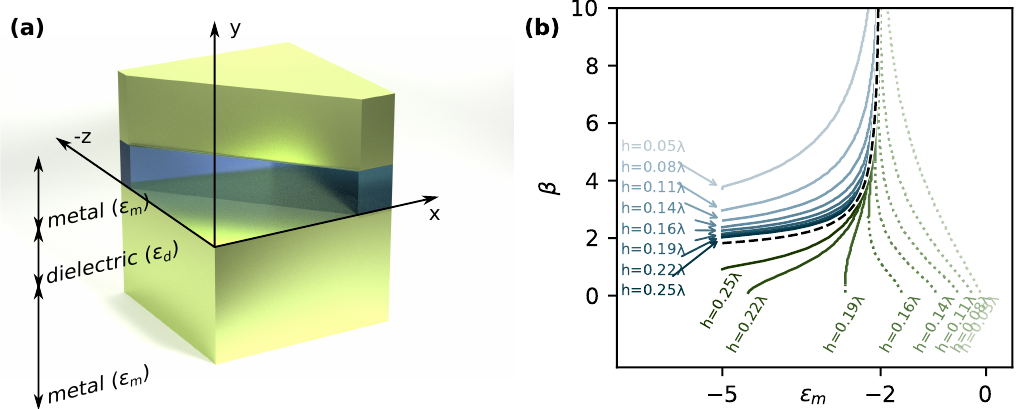
Figure 1. ( a ) Geometry for isotropic three-layer system under consideration, metal-dielectric-metal layers. A dielectric (spacer) layer with thickness, h , is sandwiched between two metal layers. ( b ) Propagation constant of modes, β in three-layer system for various spacer layer thicknesses, h . Blue lines indicate even modes, while green solid (dotted) lines indicate odd modes with normal (reversed) phase propagation